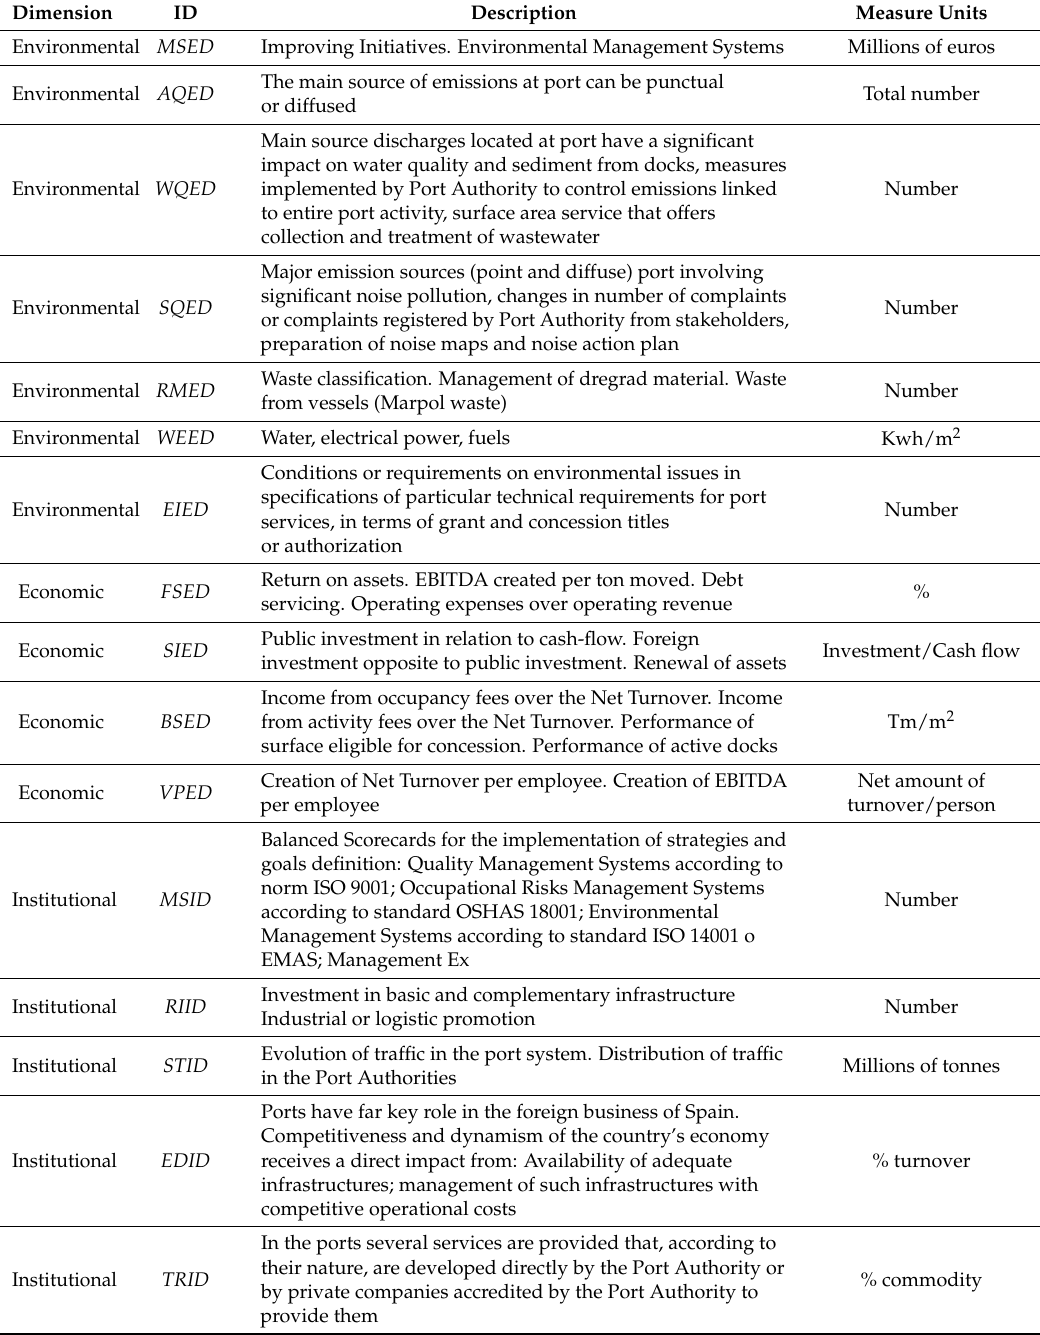
Table 1. Selected factors that have been classified in the four sustainability port